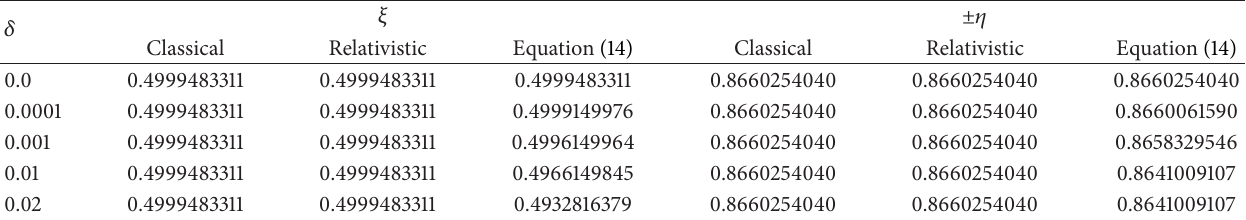
Table 10: Critical Mass. Sun-Neptune system: 𝑐 = 55148.85 , 𝜇 = = 0.0000000010 × 10 −8 . 0.000051668900 , and 𝐴 2 𝜇 𝑐 𝛿 Classical Relativistic Equation (34) 0.0 0.0385208965 0.0385208964 0.0385208964 0.0001 0.0385208965 0.0385208964 0.0385200047 0.001 0.0385208965